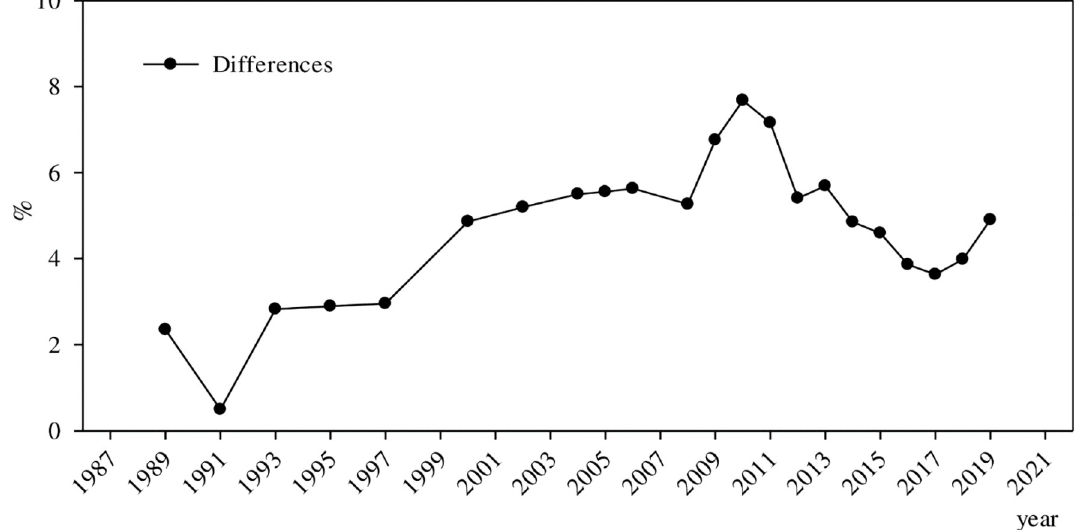
Fig 3. Evolution of the differences in returns to education between urban and rural China. Data Source : CHNS, CHIP, CGSS, CFPS, CHFS, and CSS.